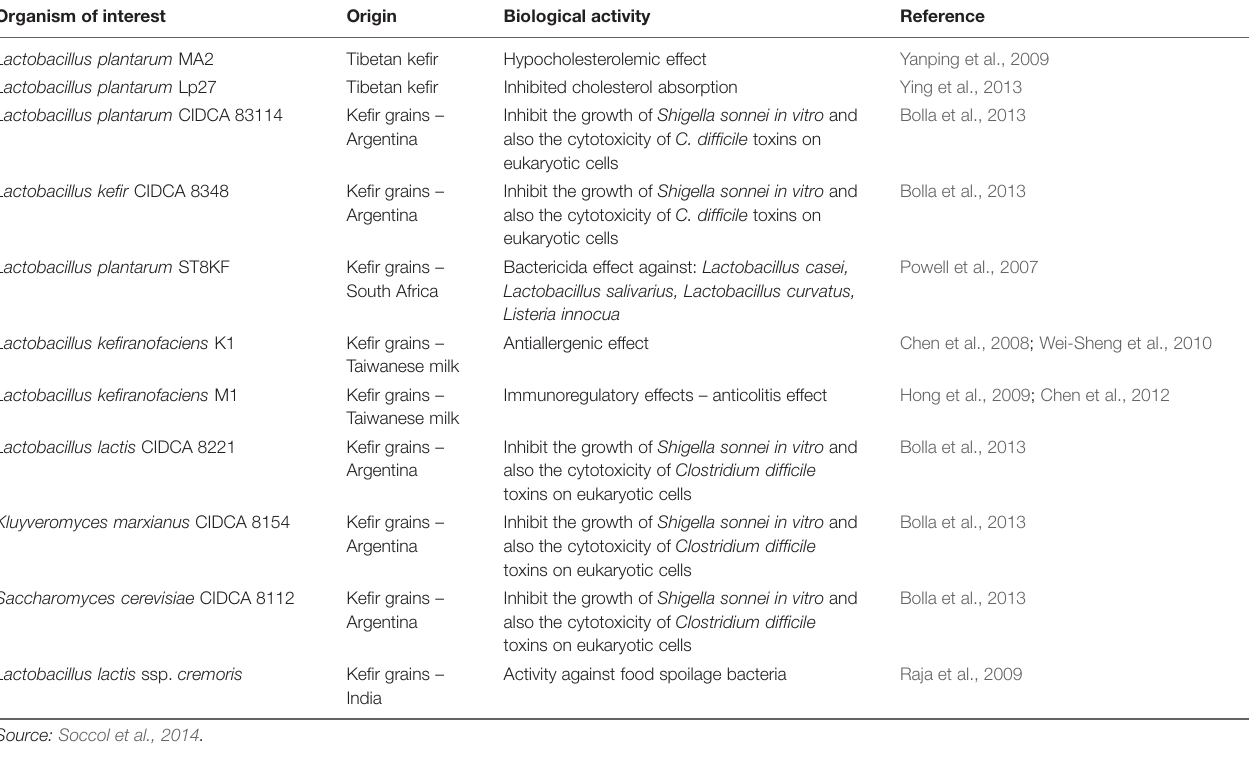
TABLE 2 | Kefir microorganisms and their biological activities.